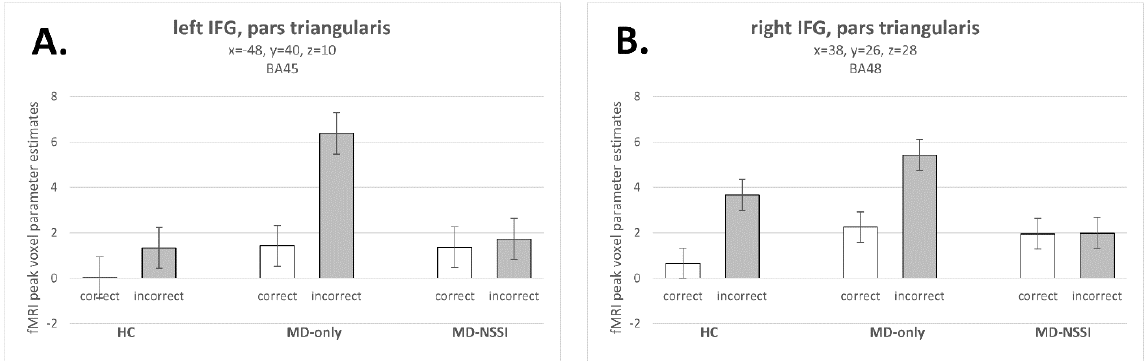
Figure 2. Neural activations of inferior frontal gyrus (IFG) for incorrect and correct incongruent No Go trials (( A ). Left IFG; ( B ). Right IFG) in depressed adolescents with comorbid non-suicidal self- injury (MD-NSSI; n = 14), adolescents with major depression (MD-only; n = 12), and healthy controls (HC; n = 14). Bar charts depict fMRI peak voxel parameter estimates extracted from significant clusters located in left (MD-only minus MD-NSSI) and right (HC minus MD-NSSI) pars triangularis of IFG; error bars depict standard error of the mean. x, y, z: MNI coordinates provided in mm; BA = Brodmann area.